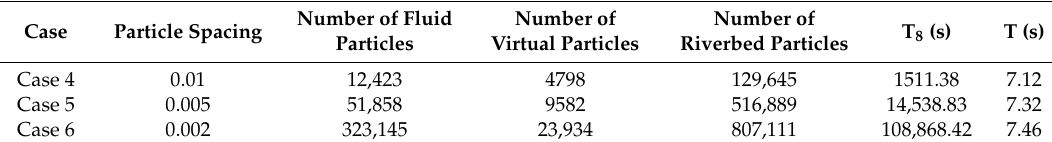
Table 6. Particle numbers for each case tested (unit: pcs). Remarks: In all three cases, 8 threads were used for parallel calculation.